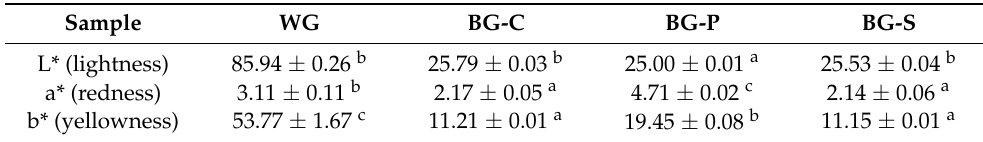
Table 3. Color parameters in L*a*b* space obtained using the instrumental method (“electronic eye”) in white garlic and black garlic products.